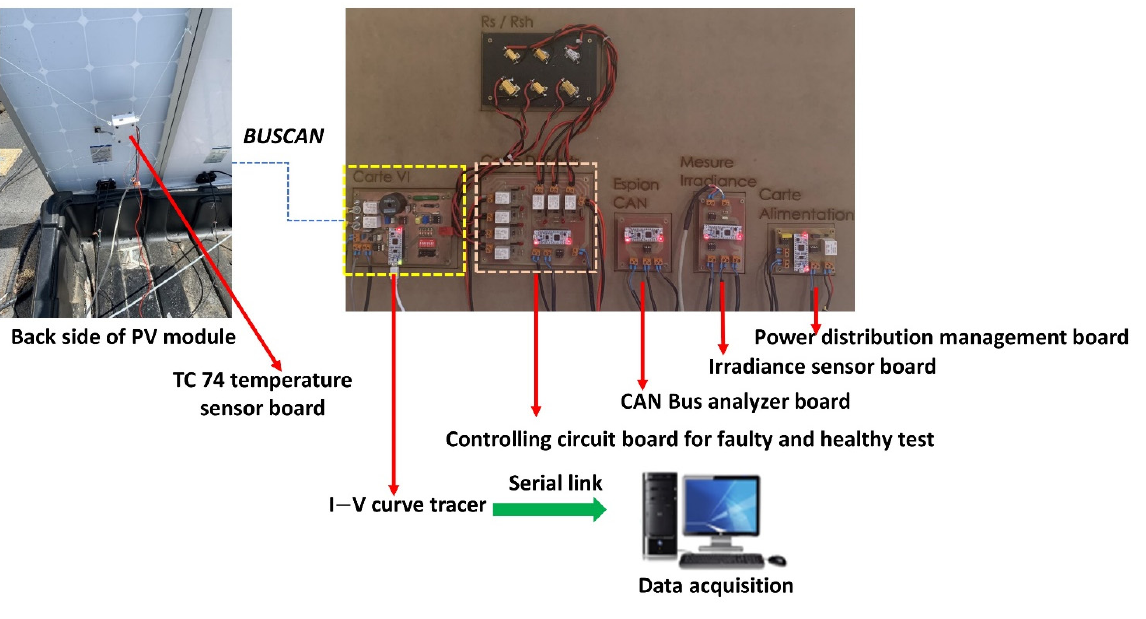
Figure 2 . Pictures of the experimental test bench . Figure 2. Pictures of the experimental test bench. Table 1. Parameters under standard test conditions (STC), G poa = 1000 W/m 2 and T pv = 25 ◦ Table 1. Parameters under standard test conditions (STC), 𝐺 (cid:3043)(cid:3042)(cid:3028) = 1000 W/m (cid:2870) and 𝑇 (cid:3043)(cid:3049) = 25 ℃ . Electrical Performance under Standard Test Conditions (STC)